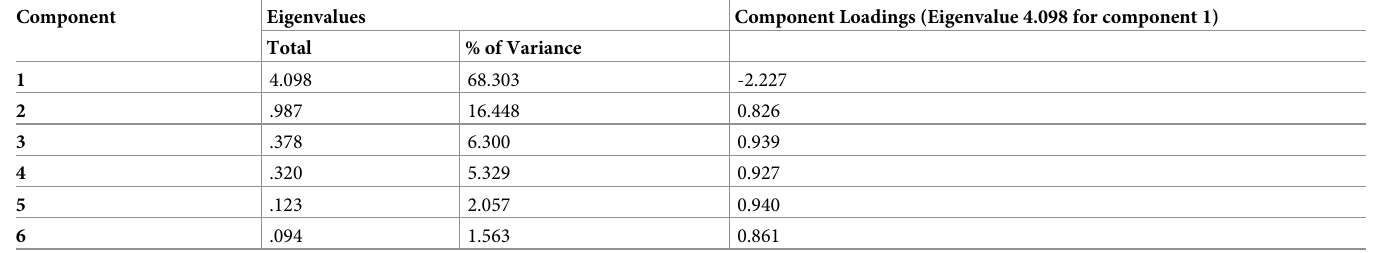
Table 8. Principal component analysis and component